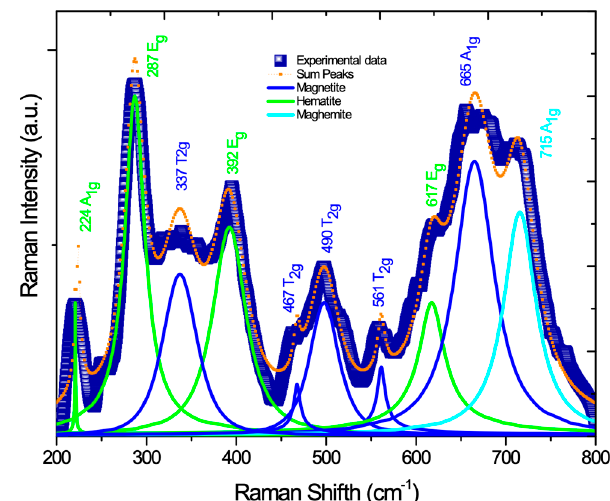
Figure 5. Deconvolution analysis of the Raman spectra of Fe 3 O 4 NPs. Table 3. Deconvolution of Raman spectra for the quantification of iron oxide phases obtained by green synthesis